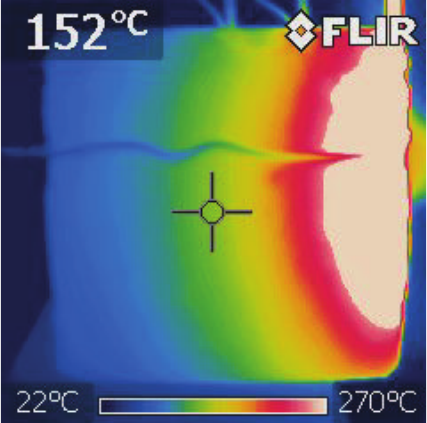
Figure 9: Thermophotograph immediately after the test, specimen CEM I - GR-SCC.